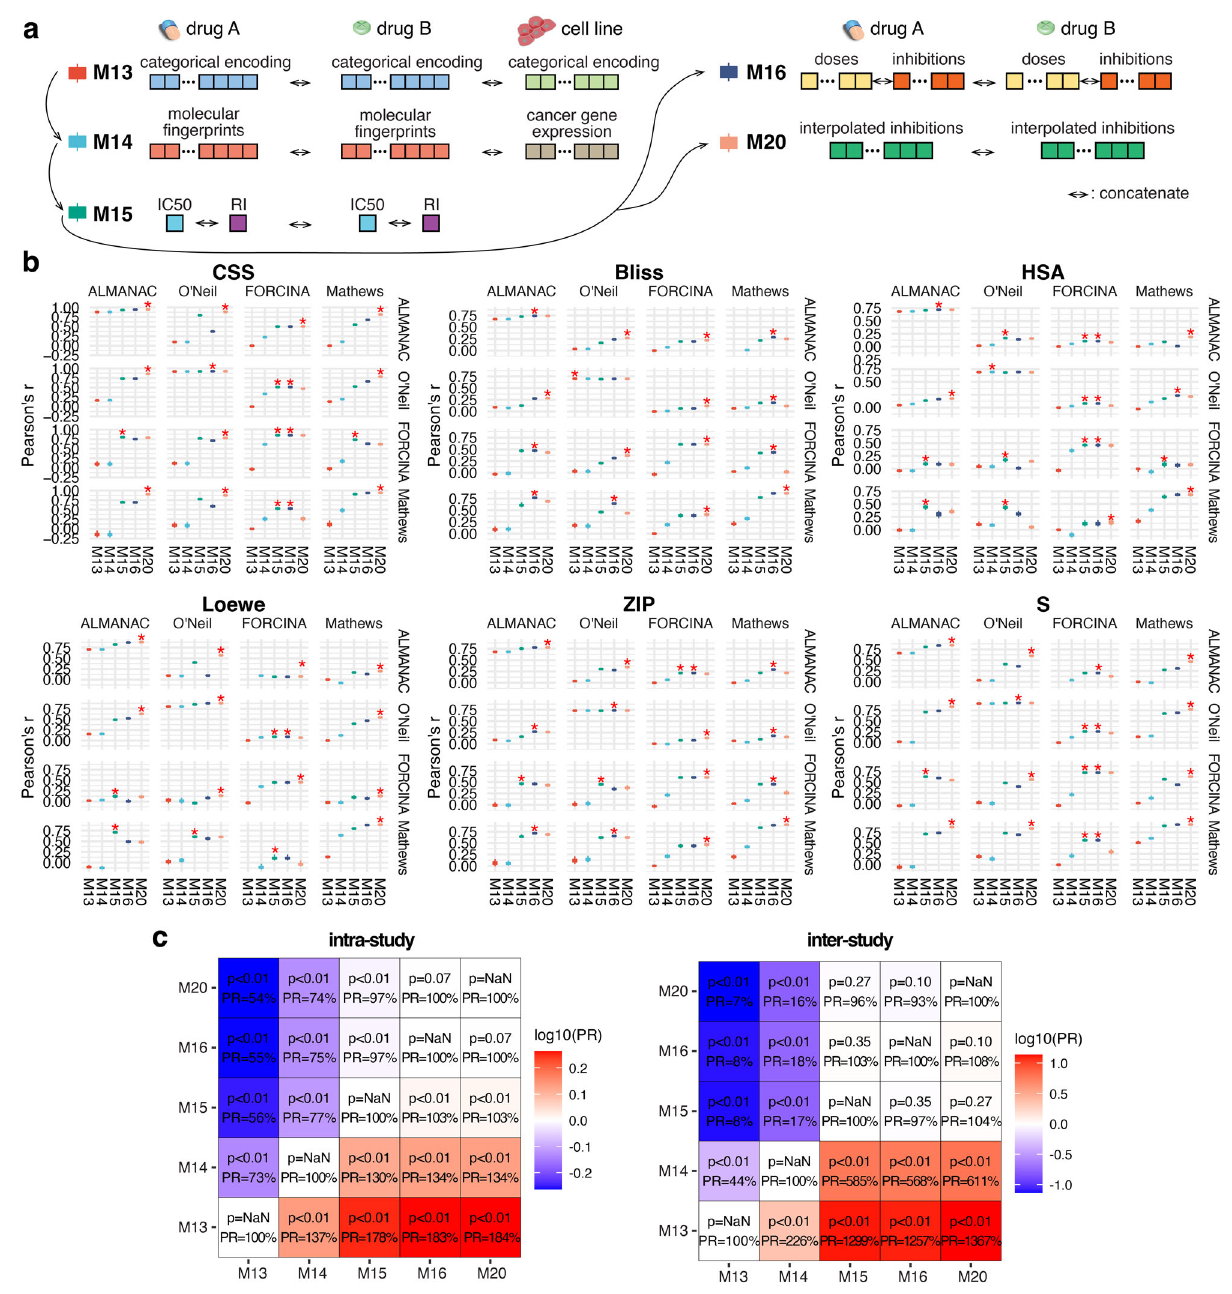
Fig. 3 Normalized dose – response information improves the intra- and inter-study prediction performances of benchmark models. a Schematic of the step-by-step feature construction strategy from the benchmark models (M13 – M15) to the dose – response-curve-incorporated models (M16 and M20). b Performances in all the training and testing scenarios for M1 – M5. The best-performing models were denoted by “ * ” c Comparisons of performances of M1 – M5 from paired t test. The performance ratios (PRs) between model pairs are shown in different